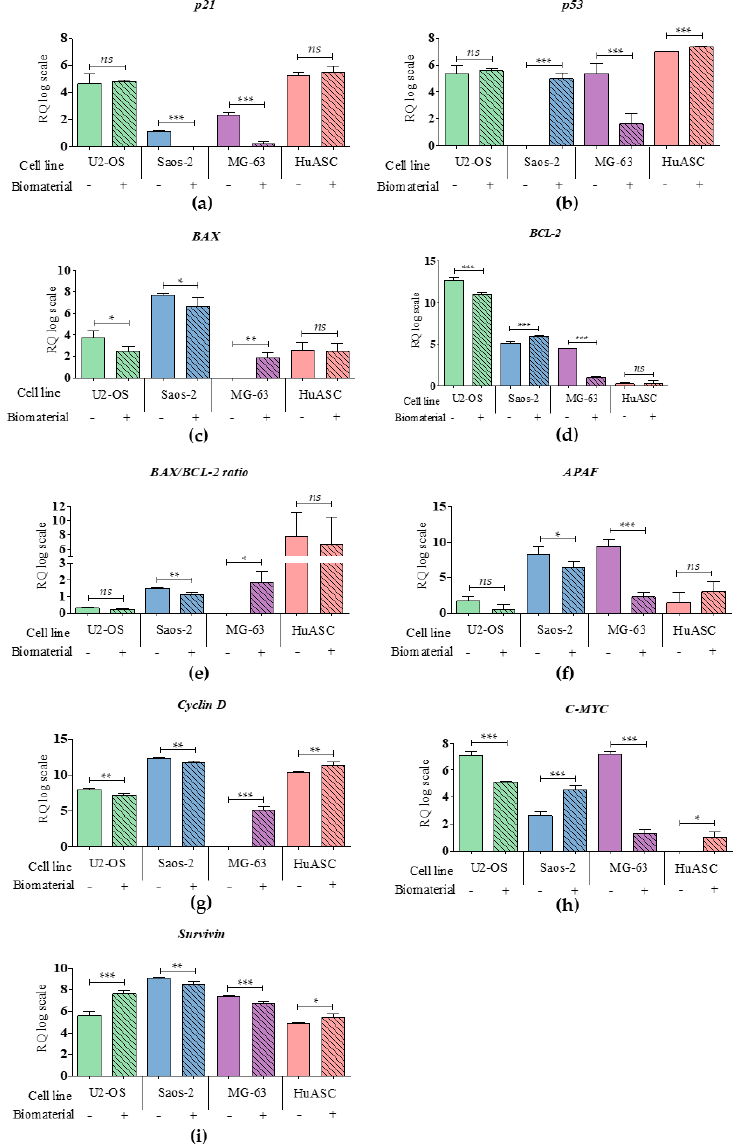
Figure 5. The analysis of mRNA level of genes associated with apoptosis and cell cycle. The examined targets were: ( a ) p21, ( b ) p53, ( c ) BAX, ( d ) BCL-2 with ( e ) BAX / BCL-2 ratio, ( f ) APAF, ( g ) Cyclin D, ( h ) C-MYC, ( i ) Survivin. An asterisk marks a statistically significant di ff erences determined between tested culture circumstances (* p < 0.05, ** p < 0.01, *** p < 0.001).The expression of genes were measured using the RT-qPCR technique, the relative quantification (RQ) was performed using 2 -DDCt method and scaling to the sample with highest expression of target gene. The results are expressed as mean ±